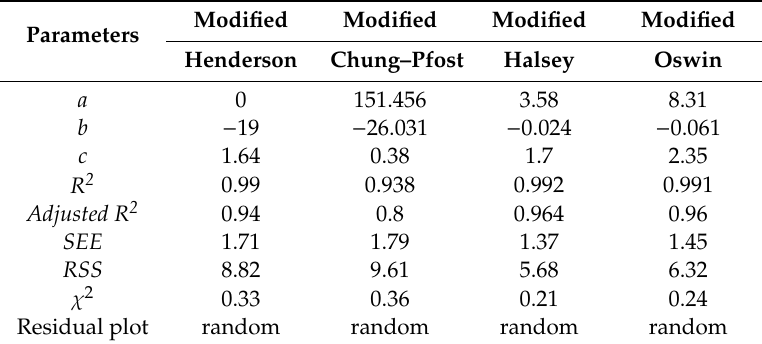
Table 5. Model coe ffi cients and statistical results for ground palm kernel.